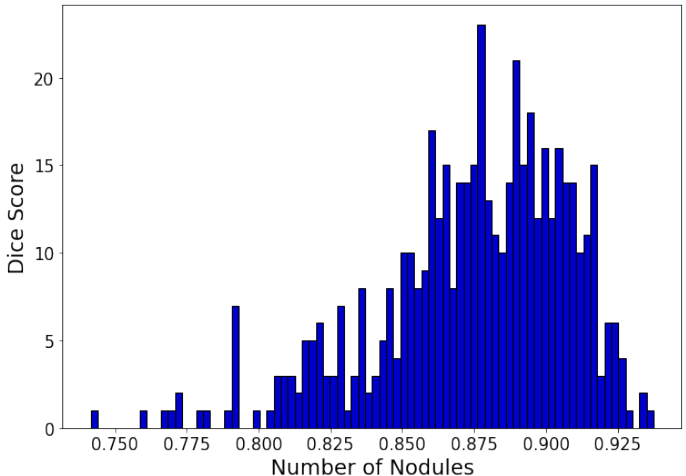
Figure 5. Dice similarity score distribution obtained on the LIDC testing set.